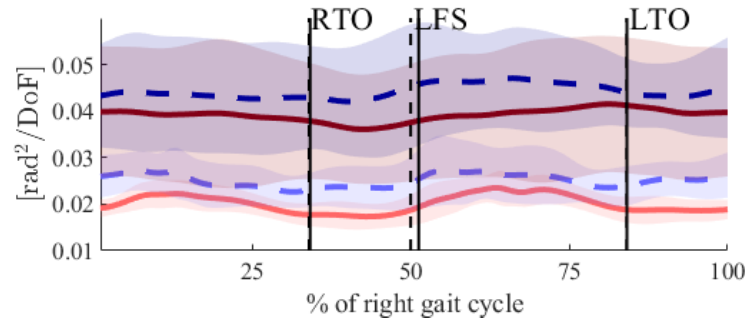
Figure 1. Time courses for UCM ꓕ (light-red and light-blue lines) and UCM ‖ (dark-red and dark-blue lines), PRE (solid lines) and POST (dashed lines) fatigue. The perpendicular black lines show the gait events right toe off (RTO), left foot strike (LFS) and left toe off (LTO). Solid lines are the gait events PRE fatigue, and dashed lines are the gait events POST fatigue.